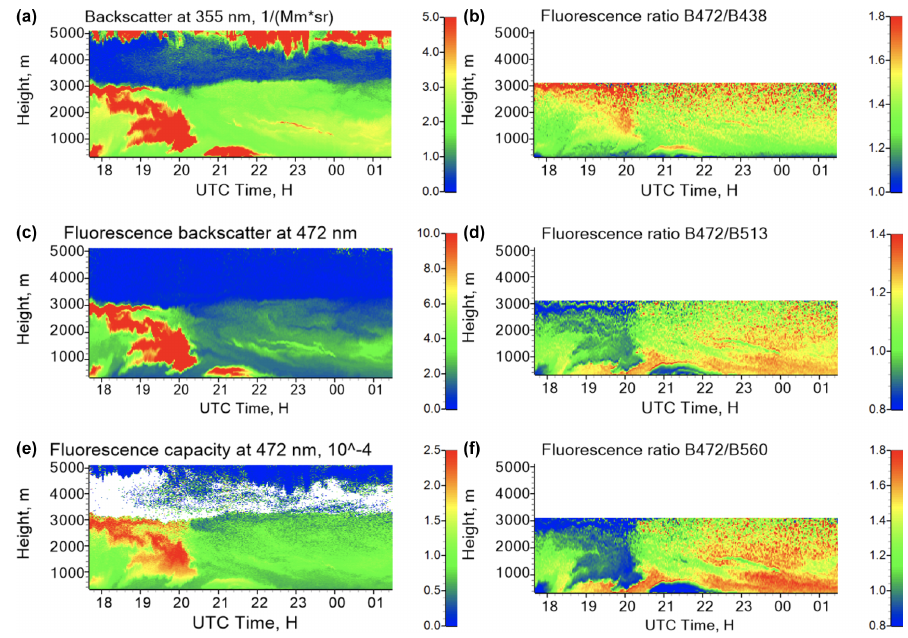
Figure 3. Spatiotemporal distribution of particle parameters on the night of 27–28 August 2022. (a, c, e) Aerosol-backscattering coefficient β 355 , fluorescence backscattering β F472 (in 10 − 4 Mm − 1 sr − 1 ) and fluorescence capacity G 472 . (b, d, f) Ratios of fluorescence-spectral- backscattering coefficients – B 472 /B 438 ,B 472 /B 513 and B 472 /B 560 .